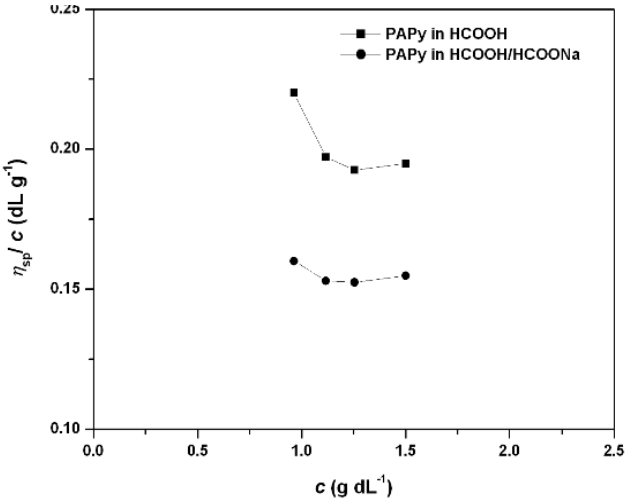
/ c versus c relationships for PAPy ( DP = 64) in HCOOH and in Figure 3. η sp HCOOH/HCOONa (0.1 M) at 30